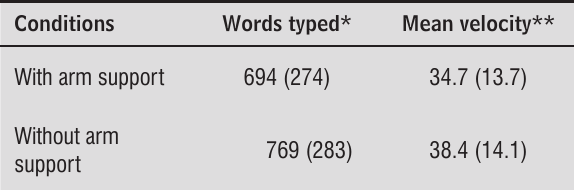
Table 1 - Number of words typed in each condition and velocity (words/minute) in mean (SD)